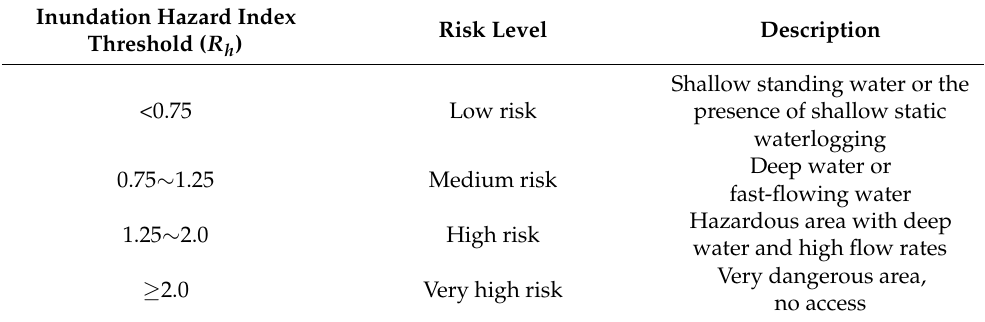
Table 2. Flood risk classification.